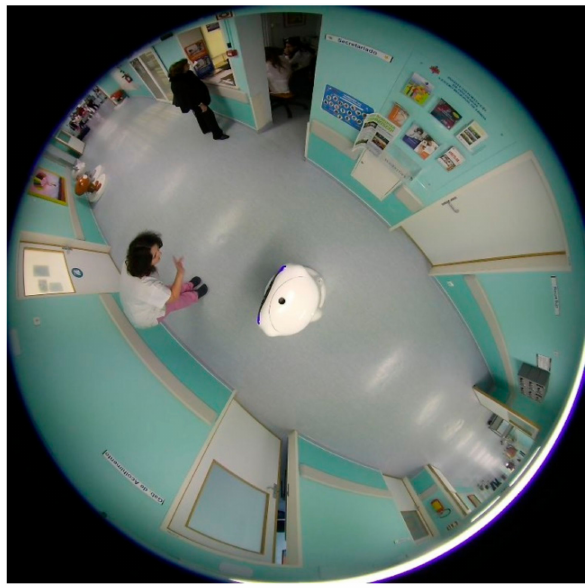
Figure 5. Hospital staff member spontaneous interaction with the